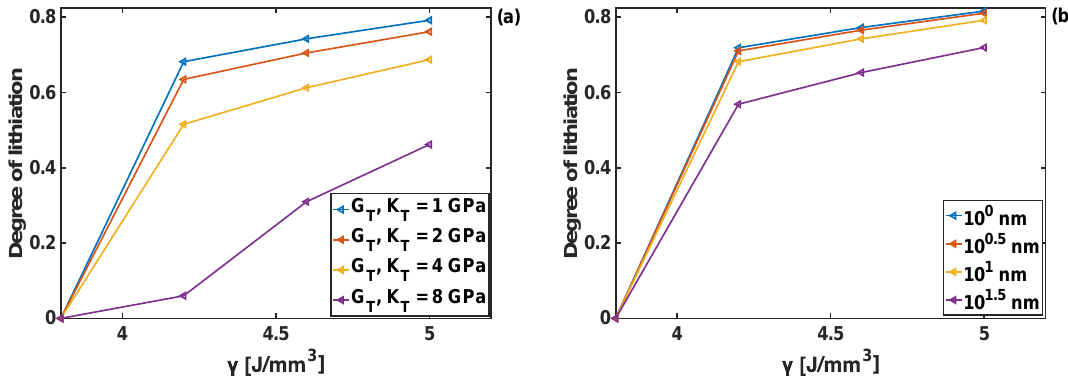
Figure 11: Degree of lithiation achieved as a function of the chemical energy parameter  ; Figure 11. Degree of lithiation achieved as a function of the chemical energy parameter γ ; ( a ) effect of coating moduli G T and K T when coating thickness h T =10 nm. ( b ) Effect of h T when G T = K T = 1 (a) effect of coating moduli G T and K T when coating thickness h T =10 nm; (b) effect of h T when G T = K T = 1 GPa.